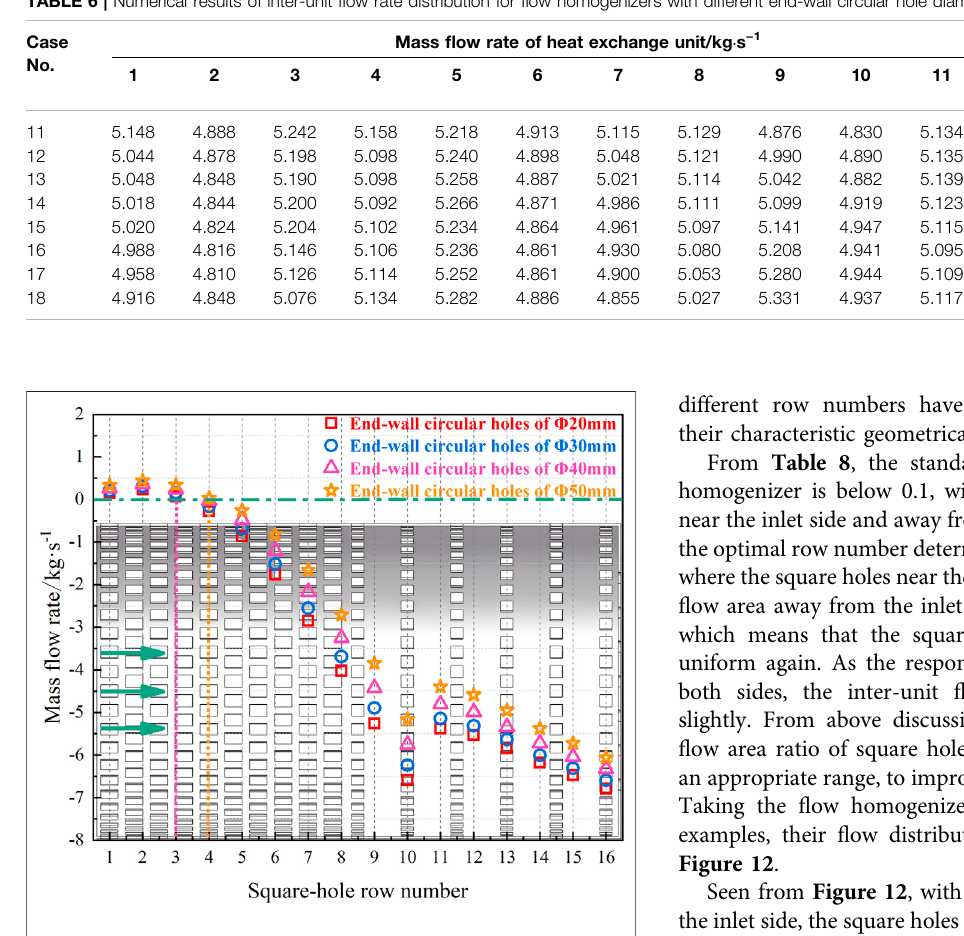
FIGURE 11 | Flow distribution characteristics of fl ow homogenizers with different end-wall circular hole